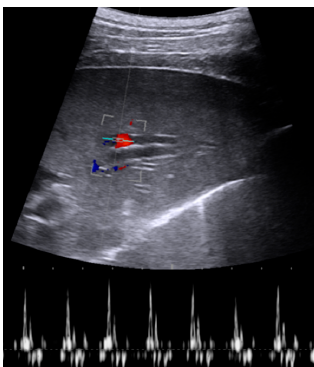
Figure 5. Doppler imaging of central through flooded lung. Pulmonary artery show typical flow characteristics and adjacent bronchus with absence of Doppler signal.